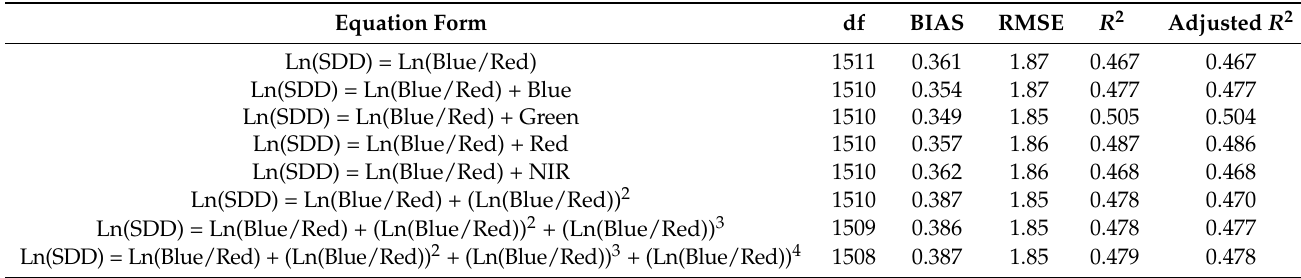
Table 3. Expanded regression models estimating in situ SDD from Landsat 8 Blue/Red surface reflectance using additional terms or different order polynomial models. Models use data for the seven-day temporal window between date of in situ sample and date of satellite overpass. (df = degree of freedom; RMSE = root mean square error).